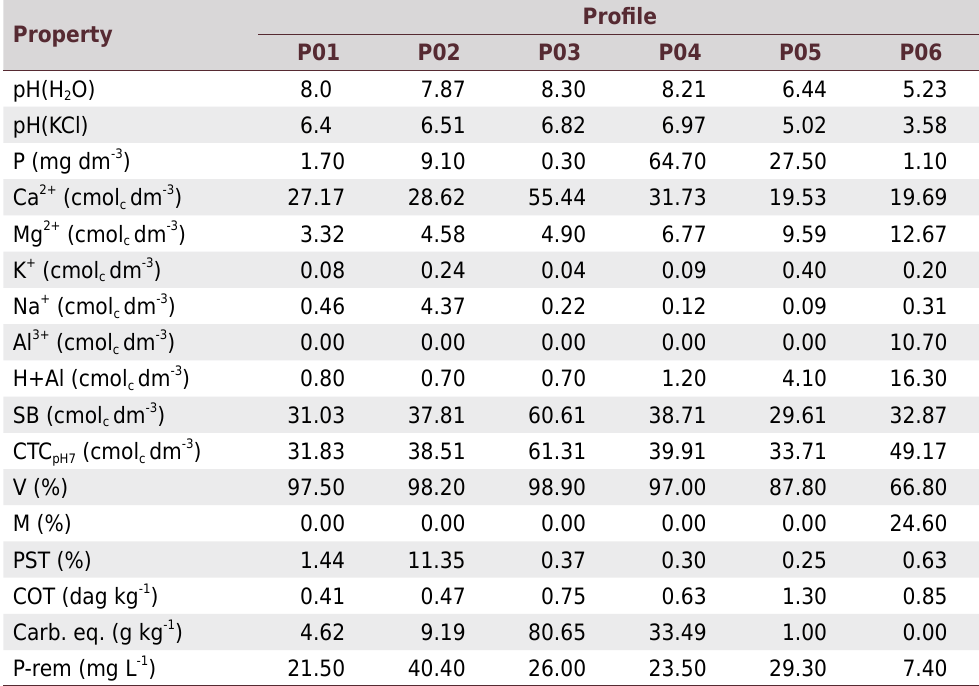
Table 3. Chemical properties of the six Vertisols sampled in Bahia State Property